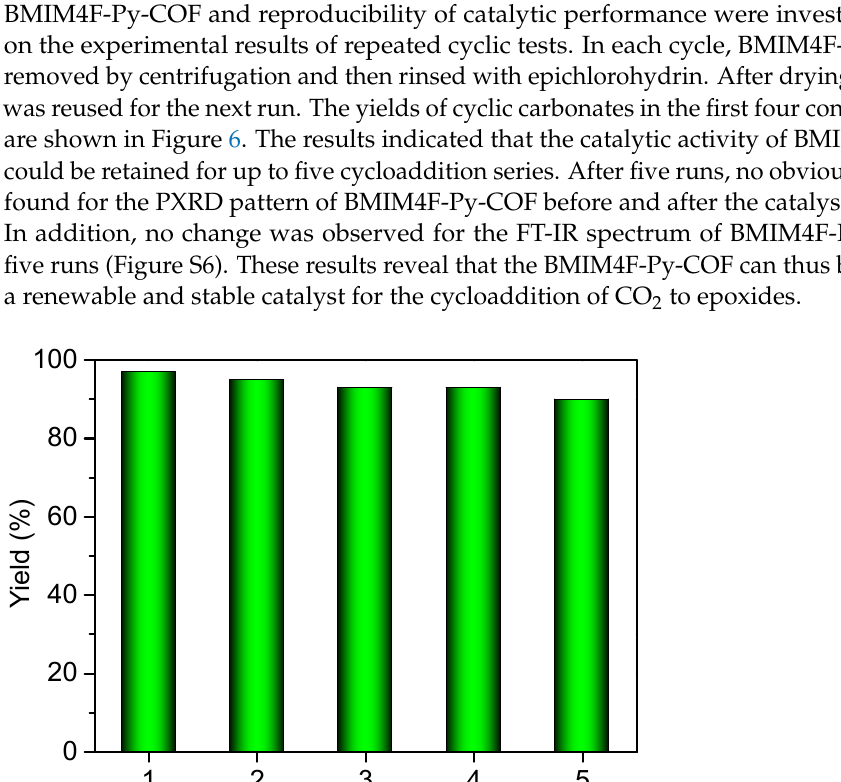
Table S1: Fractional atomic coordinates for the unit cell of IM4F-Py-COF; References citation of [55,56]. Table S2: Comparison with various metal-free catalysts in the performance of the cycloaddition